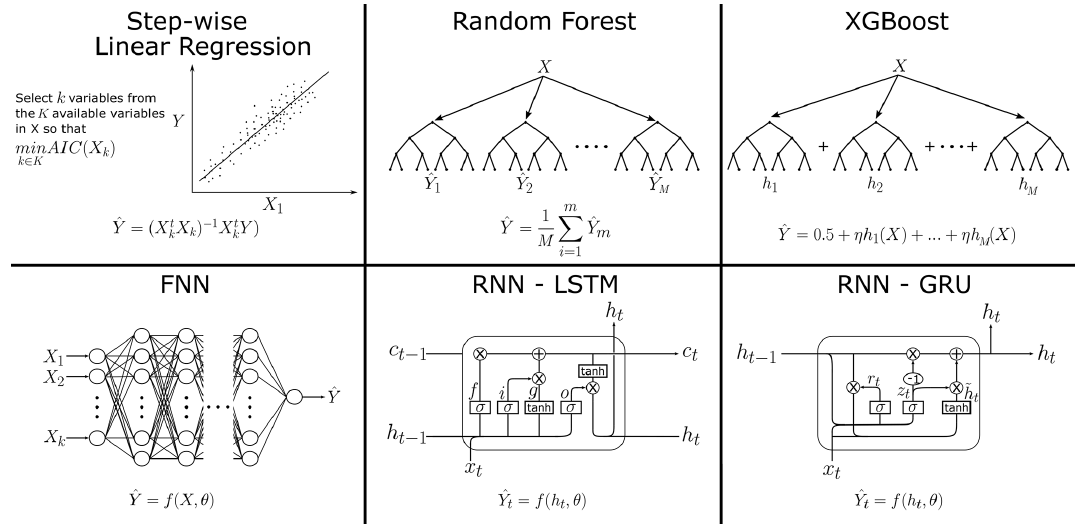
Figure 2. Overview of the applied models with ˆ Y denoting estimated water temperatures and X the matrix of observed variables. ˆ Y 1 ,...,M are the predictions from individual RF trees. h 1 , ...,M are the predicted residuals from individual XGBoost trees. f (X,θ) denotes a mapping from a FNN with the parameters θ . For a given time step, h t denotes the hidden internal state of a RNN cell, c t the internal cell state of a LSTM cell and f (h t ,θ) the mapping from a RNN with the parameters θ . RNNs consist of a cascade of cells, each feeding their internal states into the next cell, finally resulting in a single feed-forward layer estimating ˆ Y from h t